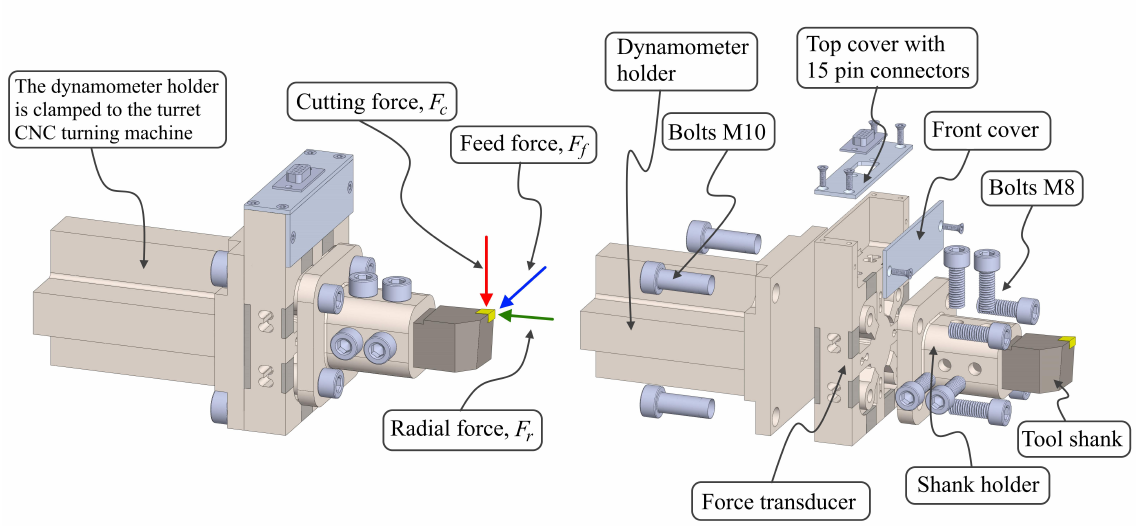
Figure 2. Structure of the dynamometer model and an explosion view of the primary component.